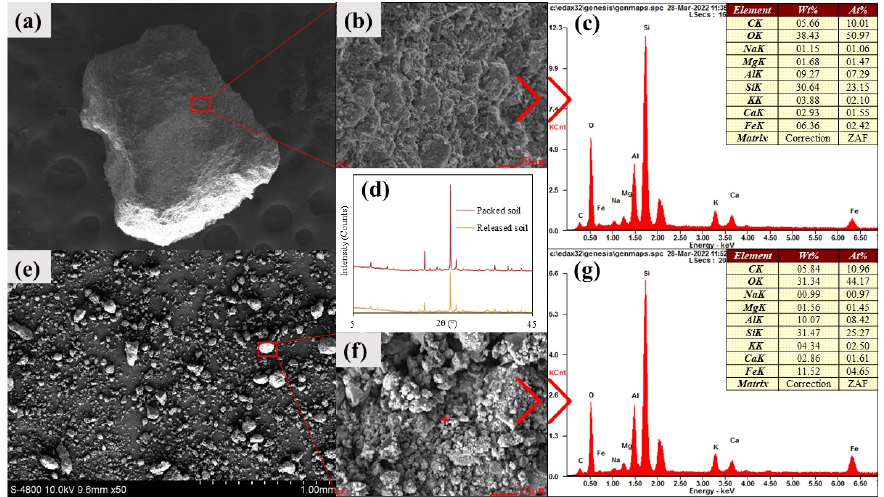
Figure 6. SEM images, EDS, and XRD ( d ) of packed soil aggregate ( a – c ) and released soil particles ( e – g ) (rectangles in ( a , e ) do not represent the true scales).